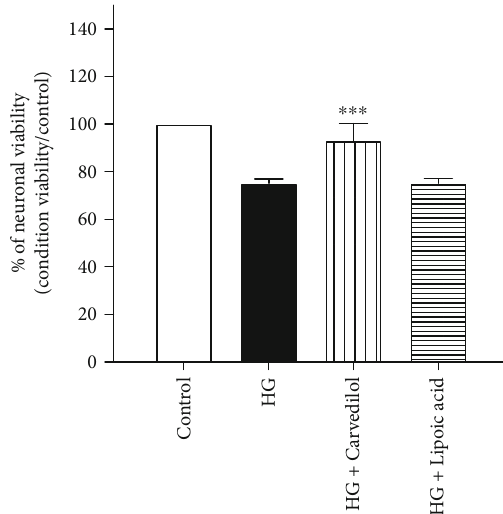
Figure 4: Carvedilol e ff ect on HG-induced decreases in DRG